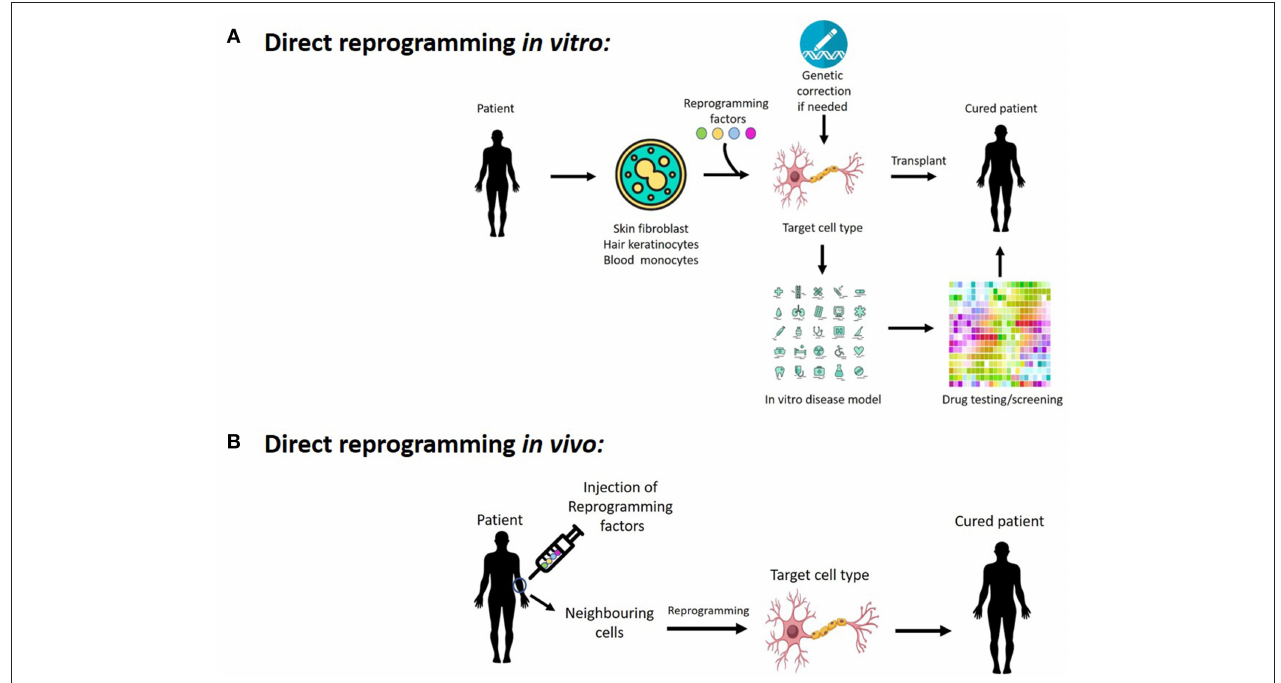
FIGURE 1 | Potentials of cellular reprogramming (A) in vitro and (B) in vivo for regenerative medicine, disease modeling, as well as drug discovery and testing gene therapy.